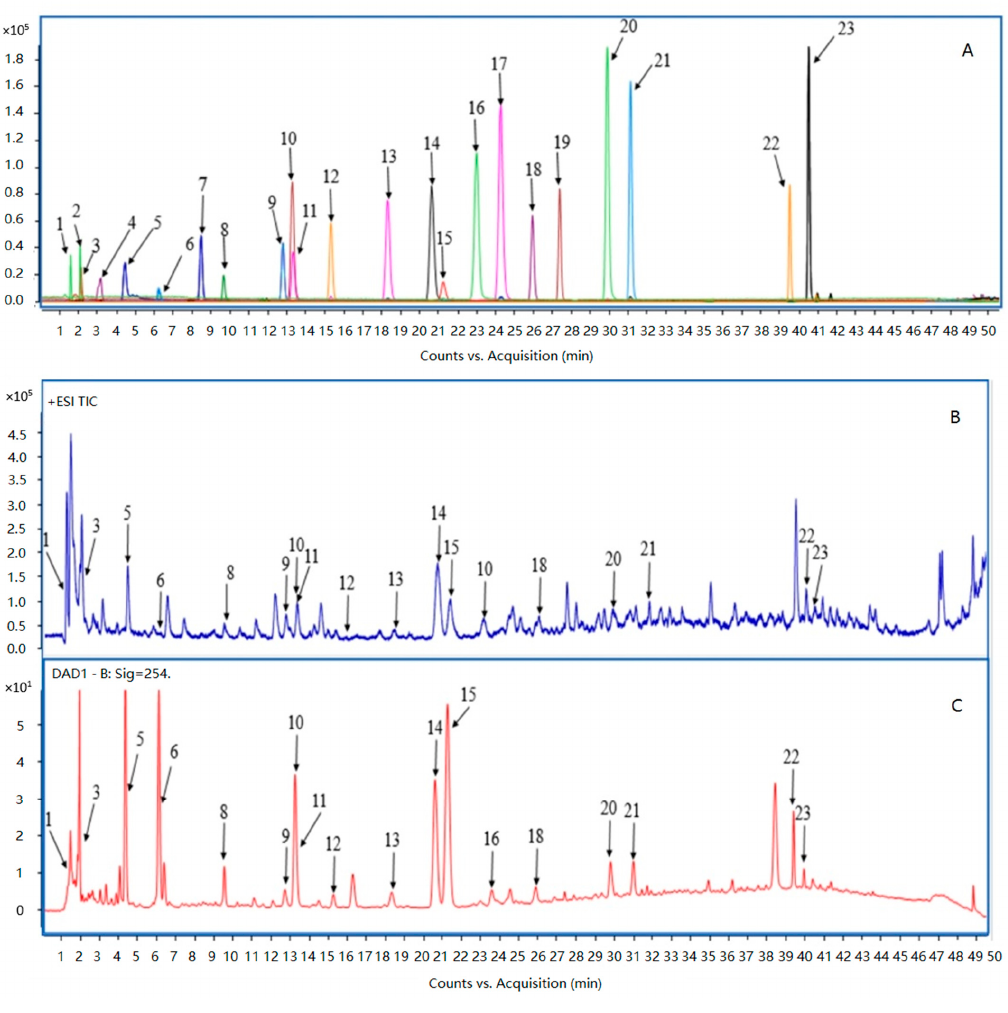
Figure 1. Liquid chromatography/quadrupole-time-of-flight mass spectrometry (LC-QTOF-MS) total ion chromatograms (TIC) of target compounds standards mixture ( A ), the PHWE extract of Bambusa chungii bamboo culm ( B ), and UPLC-DAD detection diagram of the PHWE extract of Bambusa chungii bamboo culm monitored at 254 nm ( C ). Peak identification:1. Quinic acid, 2. Arbutin, 3. Adenosine, 4. Tachioside, 5. 5-Hydroxymethylfurfural, 6. Furfural, 7. Vanillic alcohol, 8. p -Hydroxybenzoic acid, 9. Vanillic acid, 10. p -Hydroxybenzaldehyde, 11. Caffeic acid, 12. Syringic acid,